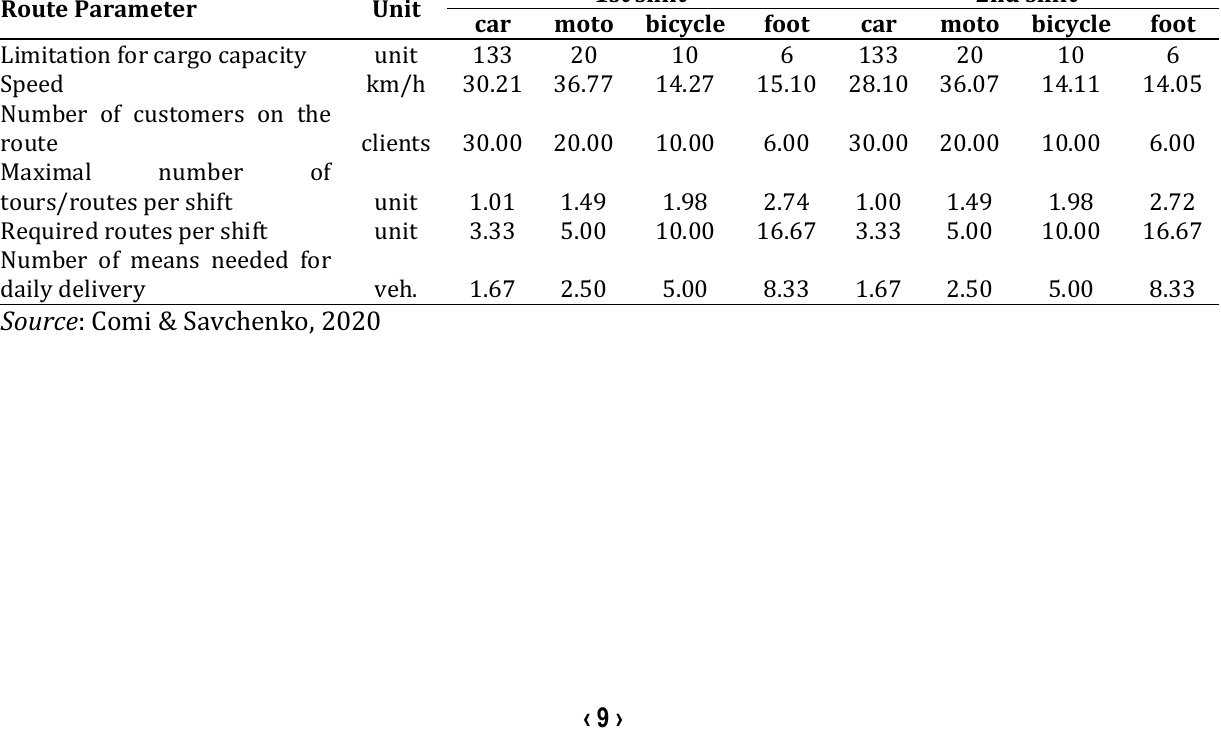
Table 1: Parameters of delivery tour/route along the working shifts Route